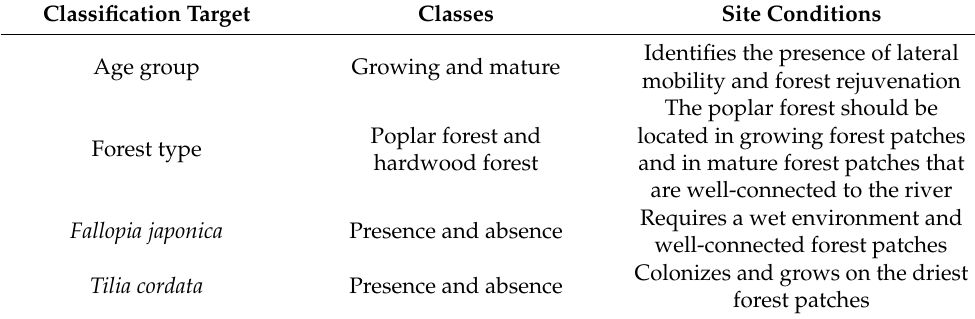
Table 4. Classification